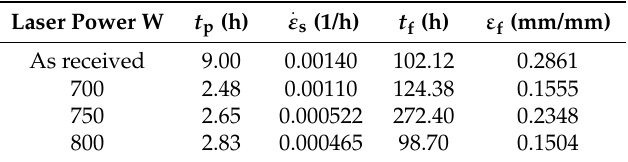
Table 1. Creep data at 600 ◦ C and 125 MPa of Ti-6Al-4V before and after laser